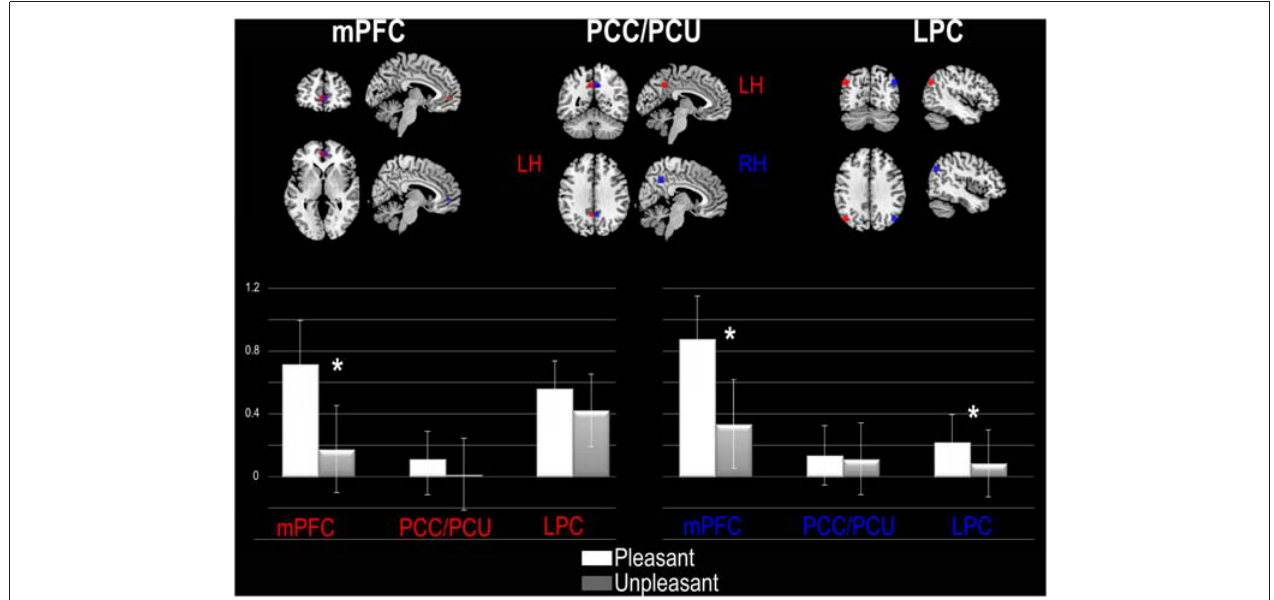
FIGURE 2 | ROI analysis based on default mode network (DMN) regions reported by Fox et al. (2005). For each DMN region the percent of MR (%MR) signal change is presented for the left (red) and right (blue) hemisphere. Abbreviations: mPFC, medial Prefrontal Cortex; PCC/PCU, Posterior Cingulate Cortex/Precuneus; LPC, Lateral Parietal Cortex; LH, Left Hemisphere; RH, Right Hemisphere. Significant statistical differences are represented by